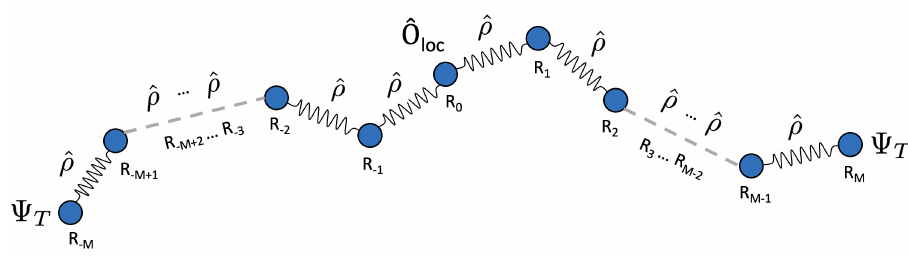
Figure 2: Visual representation of the PIGS method for the particular case when ˆ O is local in configuration space. The total number of beads is 2 M + 1, and O is calculated in the central bead R . Density matrix elements connect all internal beads. Therefore, 0 the same algorithm can be used to sample all configurations R i